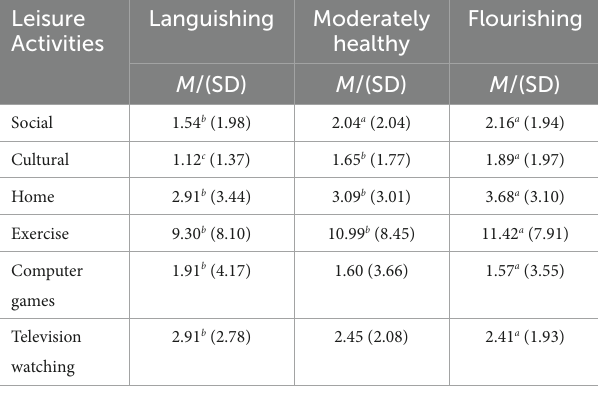
TABLE 2 Comparison of means for leisure activities by languishing, moderately healthy, and flourishing typology. Leisure